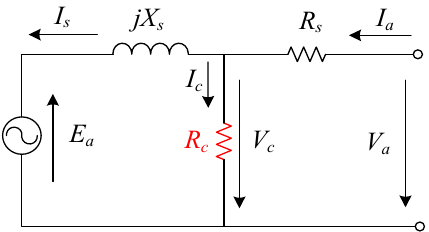
Figure 6. ECM of PMSM with R c as function of speed [10].